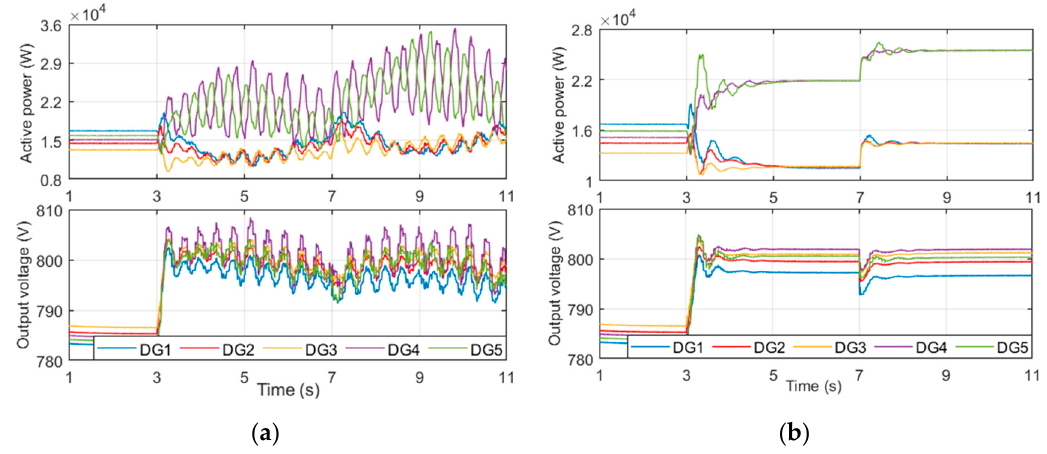
Figure 9. Simulation results under arbitrary sampling as shown in Figure 8. ( a ) Consensus algorithm. ( b ) Fast convergence algorithm.